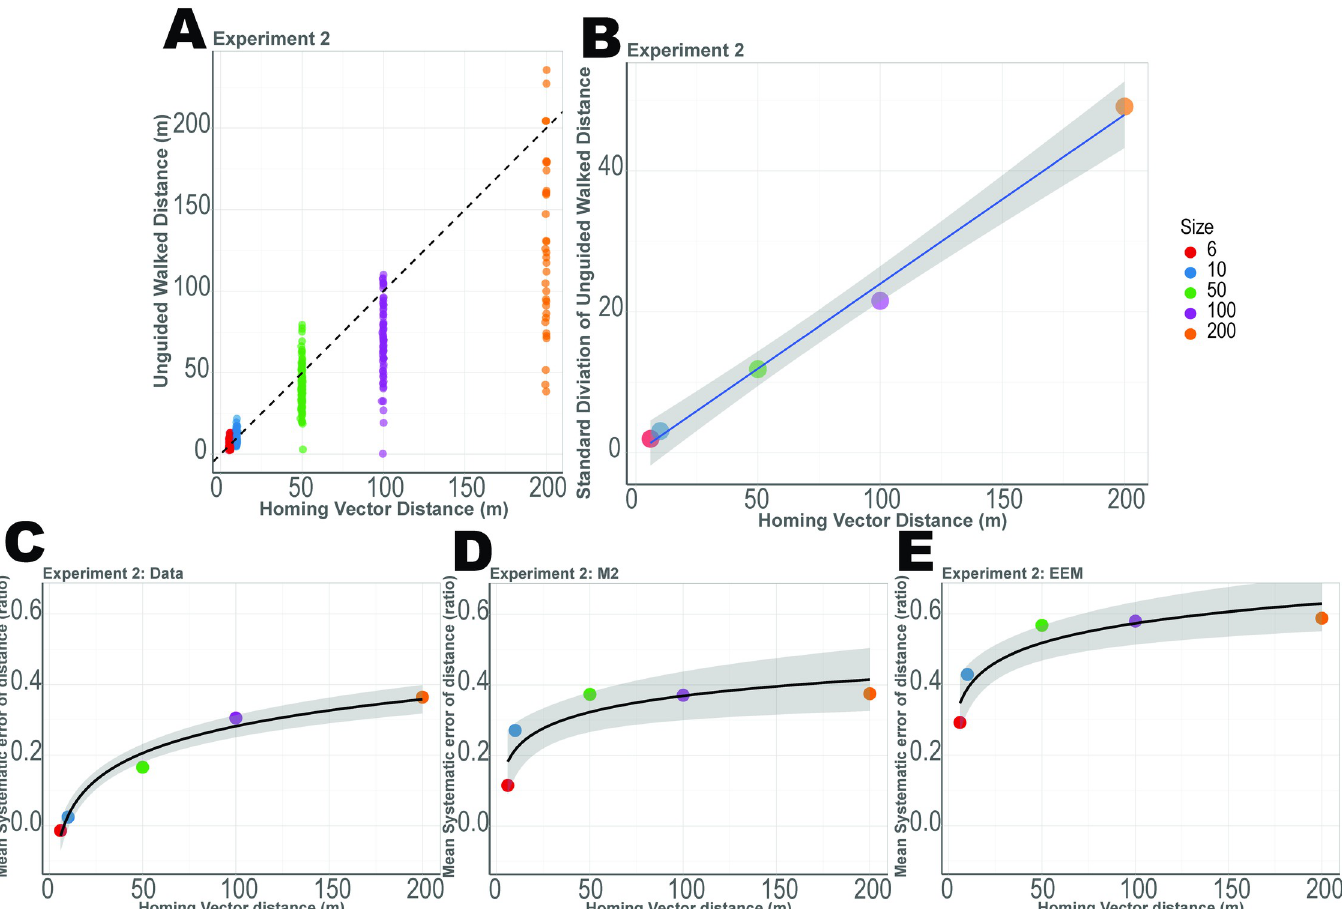
Fig 5. Systematic underestimation of distance from Experiment 2. (A) The distribution of distances for the unguided side (D) for each triangle size with y = x plotted at the dotted line. (B) Standard deviation of distances for the unguided side (D), which show a linear increase. (C) Mean systematic errors of distance (1- distance error), which increase logarithmically. (D) Mean systematic errors of distance of the simulated data from Model 2, which increase logarithmically. (E) Mean systematic errors of distance of the simulated data from Encoding-Error Model, which increase logarithmically.